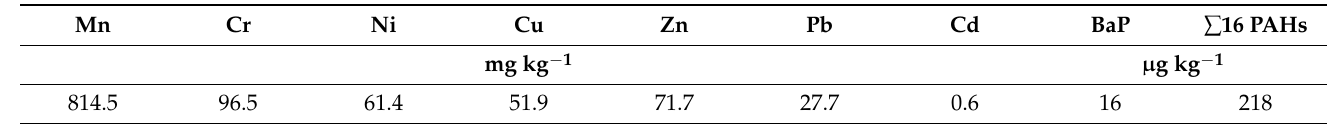
Table 1. The content of HMs and BaP and 16 priority PAHs total amount ( ∑ 16 PAHs) in the soils of the background dry steppe zone of southern Russia.